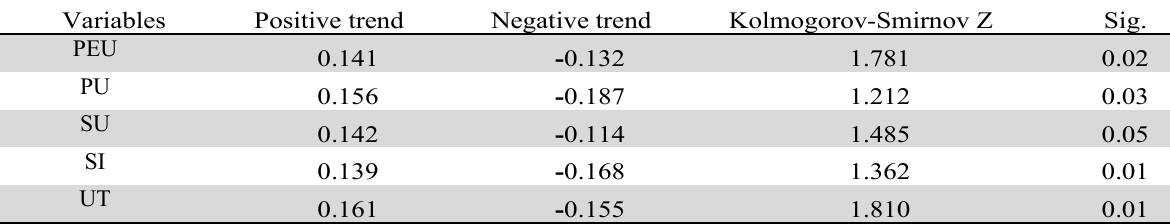
The Normal Distribution of the Variables of the study Variables